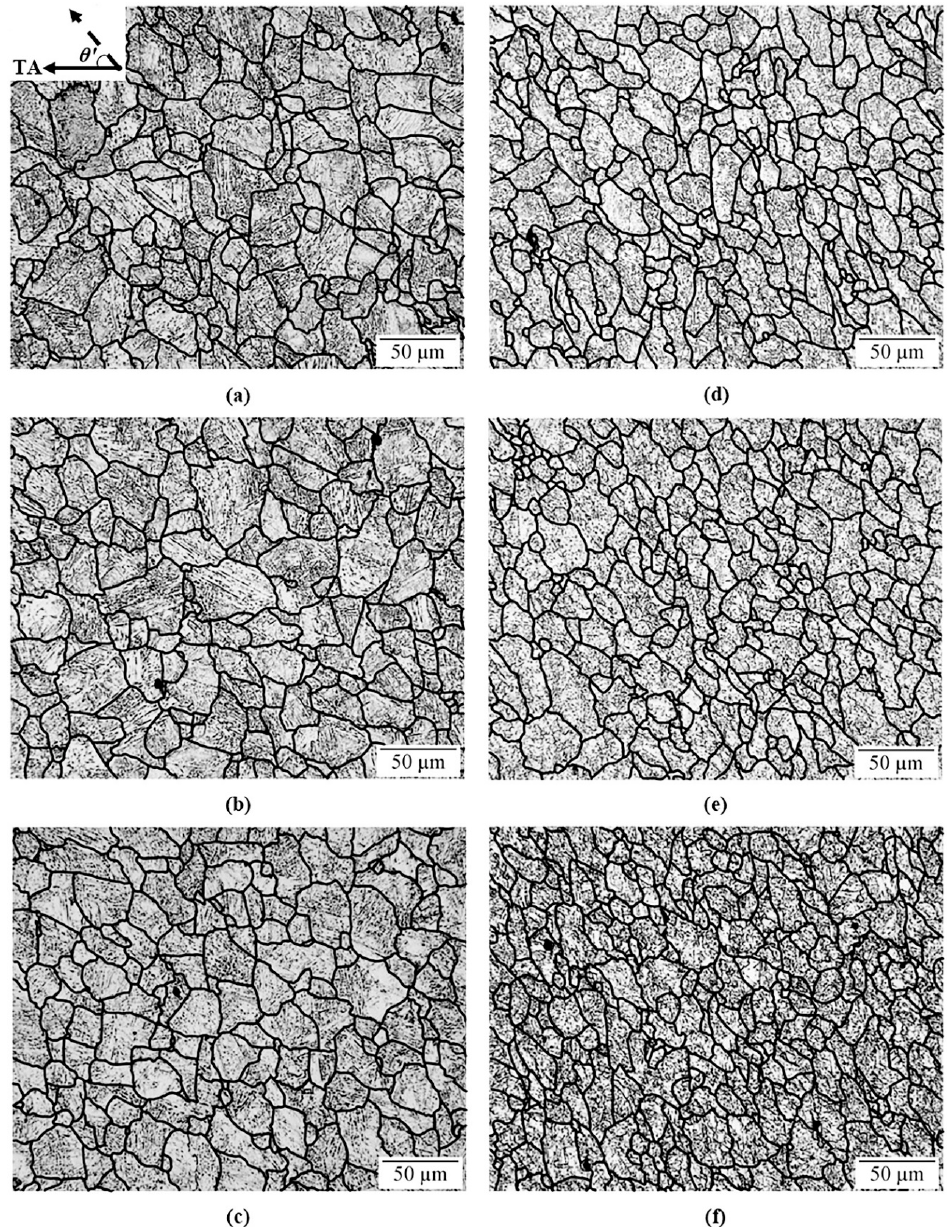
Figure 9. LOM micrographs of the prior austenite microstructures produced via ( a – c ) High T Finish and ( d – f ) Low T Finish simulations. The following radial positions are shown: ( a ) and ( d ) 0.50; ( b ) and ( e ) 0.724; and ( c ) and ( f ) 0.90. The torsional axis (TA) is horizontal to the page. Etched with a modified Béchet-Beaujard reagent, and prior austenite grain boundaries are highlighted in black.